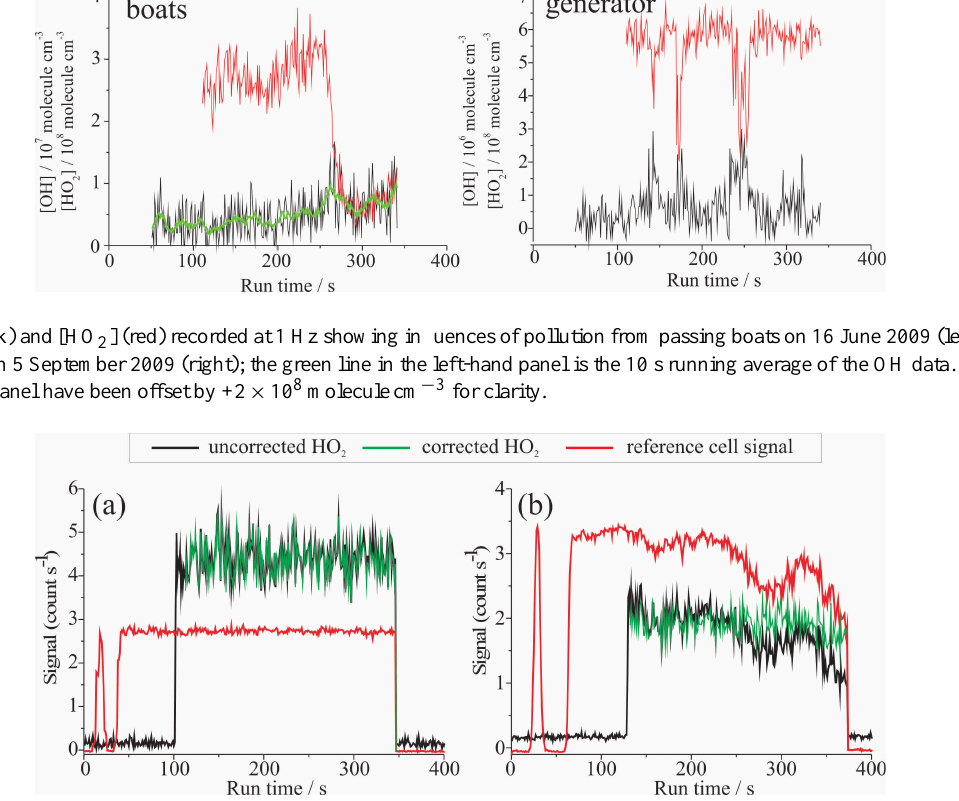
Fig. 2. Plots showing two examples of measured HO 2 signals (black line) without (a) and with (b) significant variation in the laser wave- length, observed as the response of the scaled reference cell signal (red line). The corrected HO 2 -signals are represented by the green